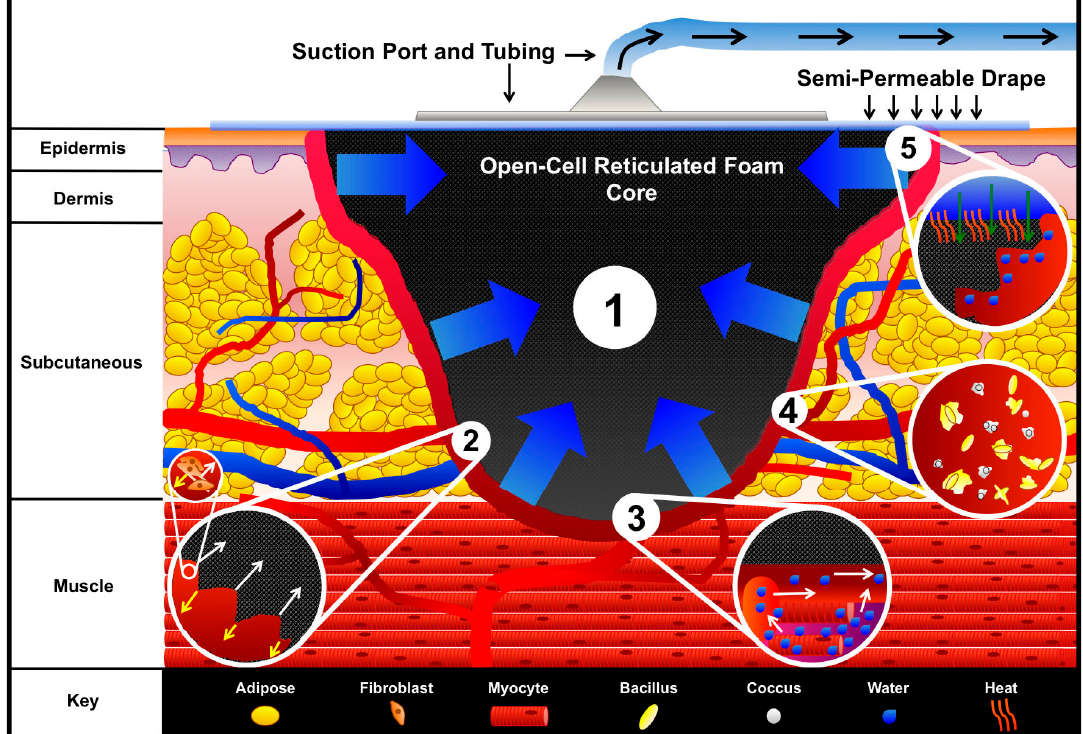
Figure 3. V.A.C. mechanisms of action. An open-cell reticulated foam is placed within the wound and covered by a semi-permeable adhesive drape. The drape is adhesively secured around and over